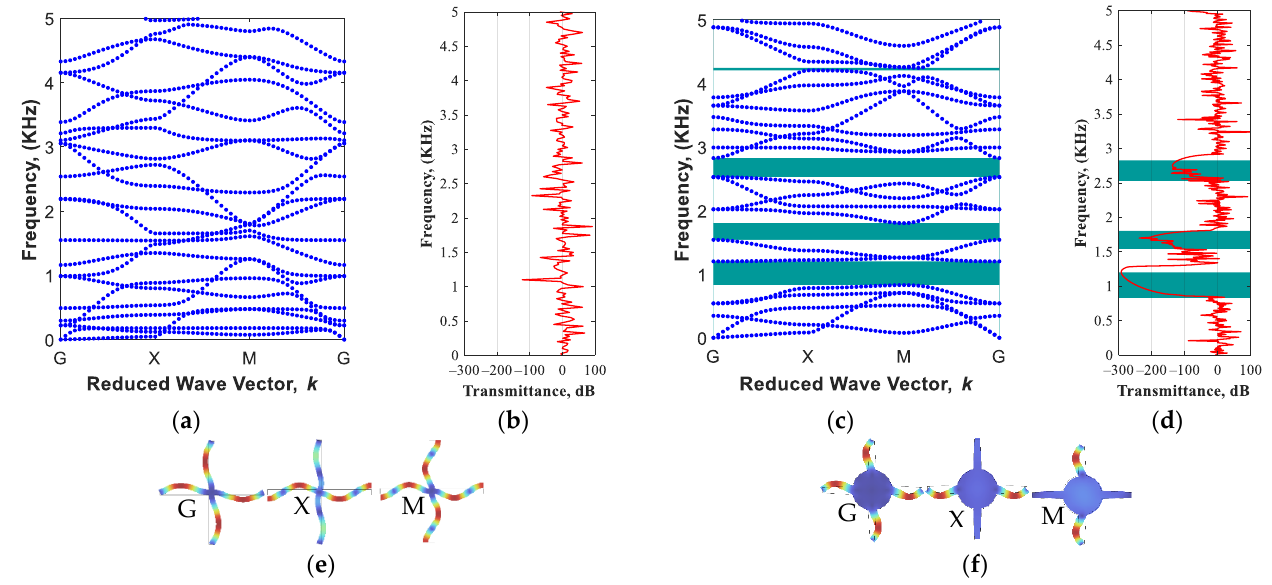
Figure 3. Initial passive design: ( a ) dispersion curves, ( b ) transmittance of conventional periodic structure based on a square lattice (Figure 1a); ( c ) dispersion curves, ( d ) transmittance of optimized periodic structure with design parameters of L / R = 5 and θ = 3 ◦ (Figure 1b); ( e ) the sixth mode shapes of the conventional lattice in various high symmetry points; ( f ) the sixth mode shapes of the modified lattice in various high symmetry points, MRE with 13.94% volume fraction.